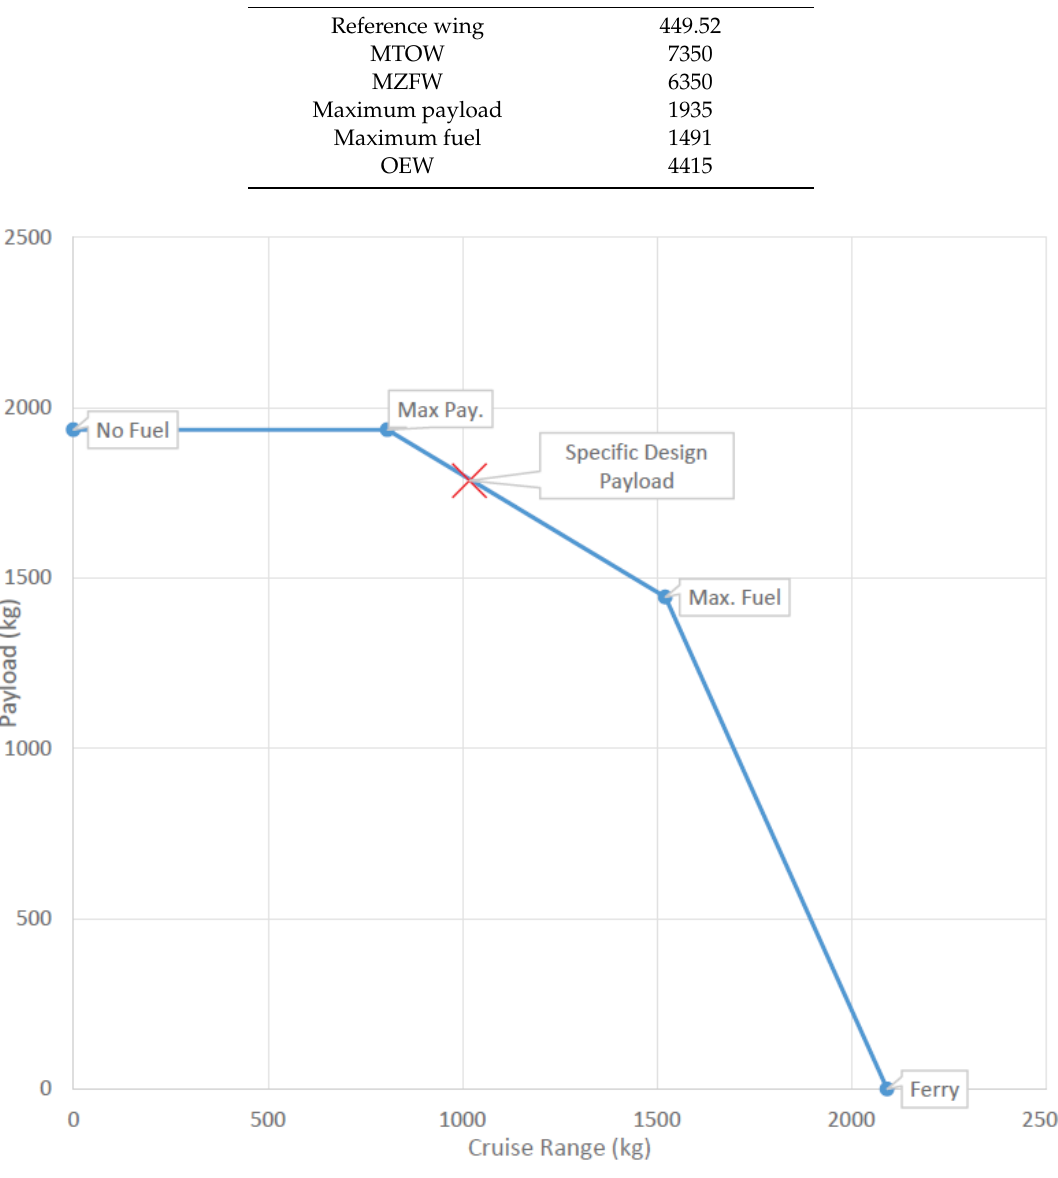
Figure 6. Payload-range diagram .